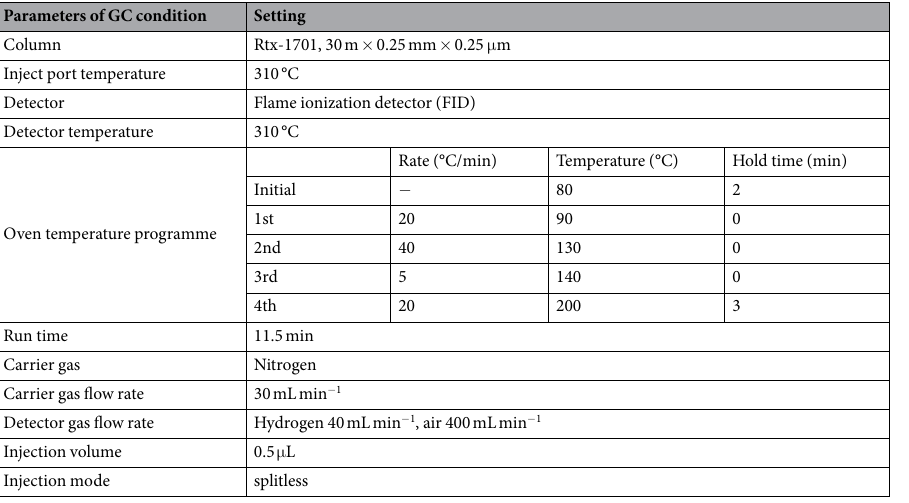
Table 3. Gas chromatograph